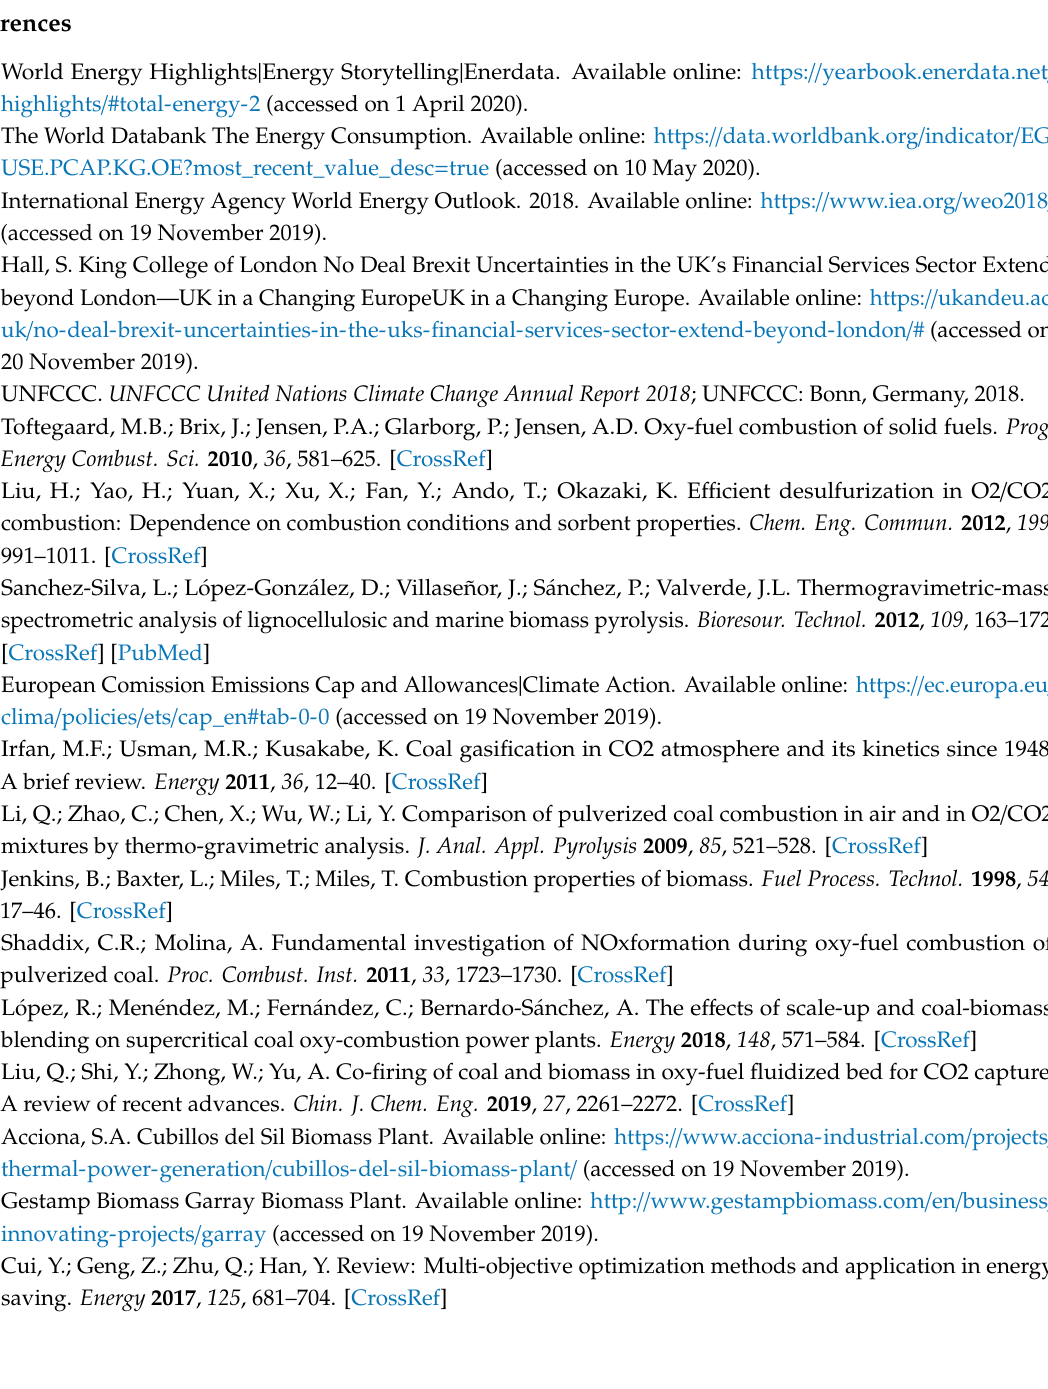
Table S1: Combination of factor values (coded and real levels) in the complete design model; Table S2: Combination of factor values (coded and real levels) in the Box–Behnken model; Table S3: Combination of factor values (coded and real levels) in the central composite models; Table S4: Training data set used in the ANN method; Table S5: The weight and the bias vectors of the neural network model for the evolution of T e ; Table S6: Validation data set used in ANN